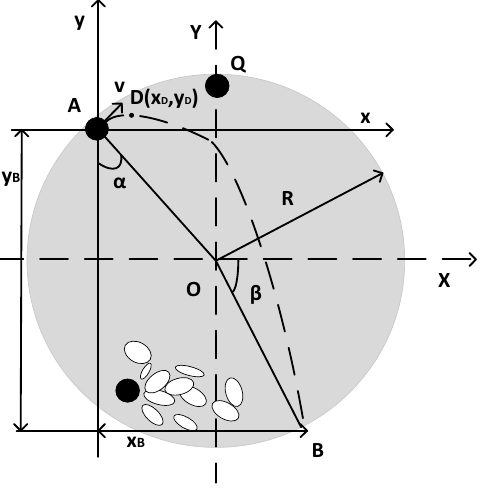
Figure 4. Trajectory of the grinding medium.